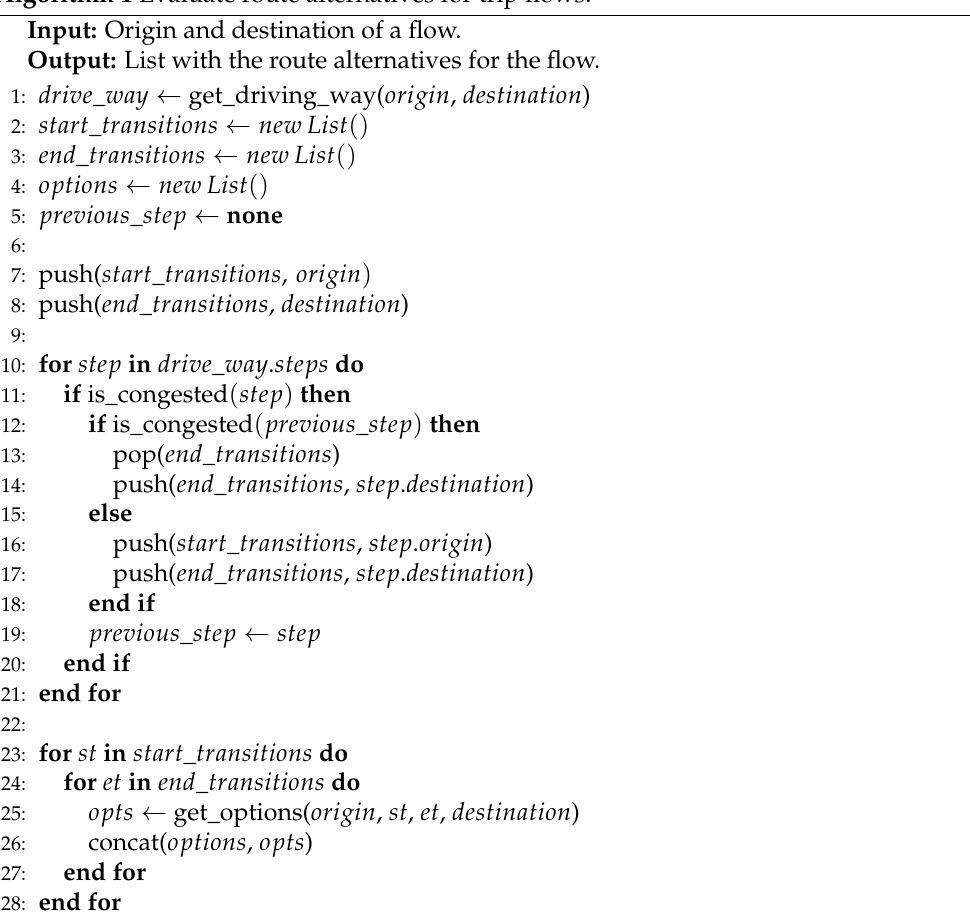
Algorithm 1 Evaluate route alternatives for trip